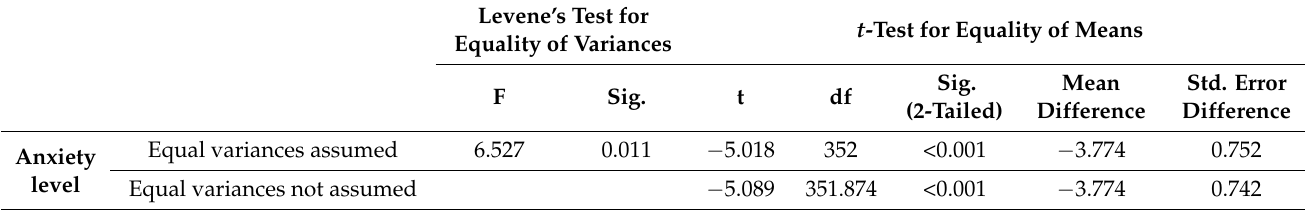
Table 5. Correlation between anxiety level and presence of GISs during the lockdown: independent samples. Levene’s Test for